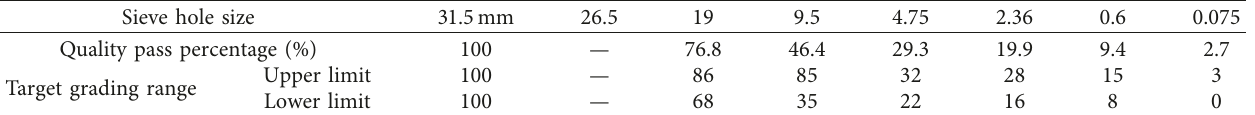
Table 1: Semirigid base mineral grading table.